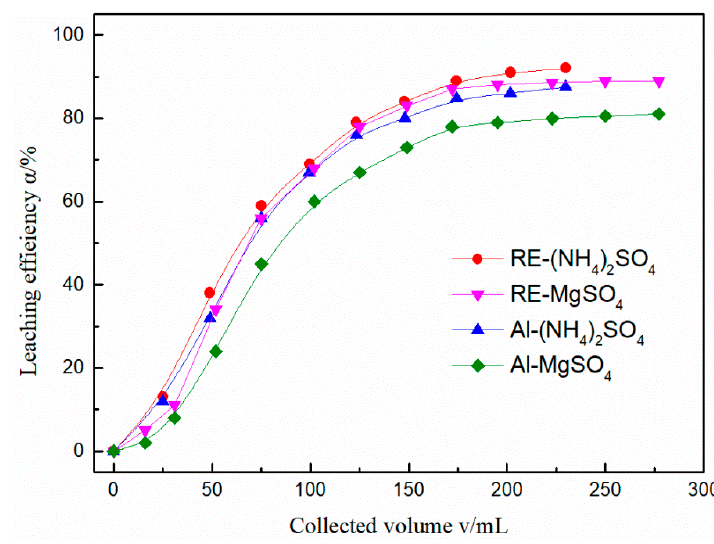
Figure 3. The leaching process of rare earth and aluminum with (NH 4 ) 2 SO 4 and MgSO 4 (250 g ore; C Mg 2+ = C NH4 + = 0.2 mol/L; liquid: solid = 1.2:1; flow rate = 0.5 mL/min; pH = 5.6; room temperature).